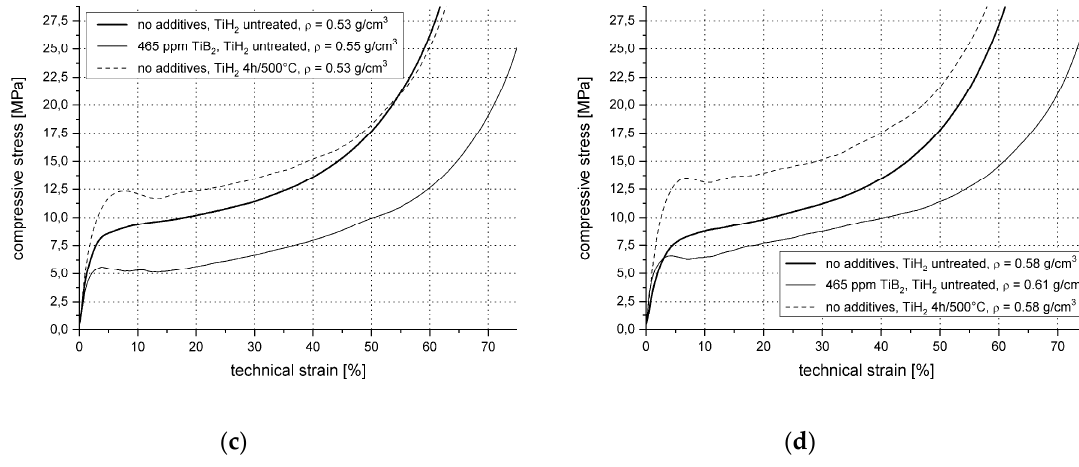
Figure 12. Compression test results—comparison between stress-strain curves associated with different density levels: 0.3 g/cm 3 ( a ), 0.4 g/cm 3 ( b ), 0.53-55 g/cm 3 ( c ), 0.58-0.61 g/cm 3 ( d ). Note the difference in the scaling of the x- (i. e., stress-) axis in Figure 12 ( a , b ) compared to ( c , d ).